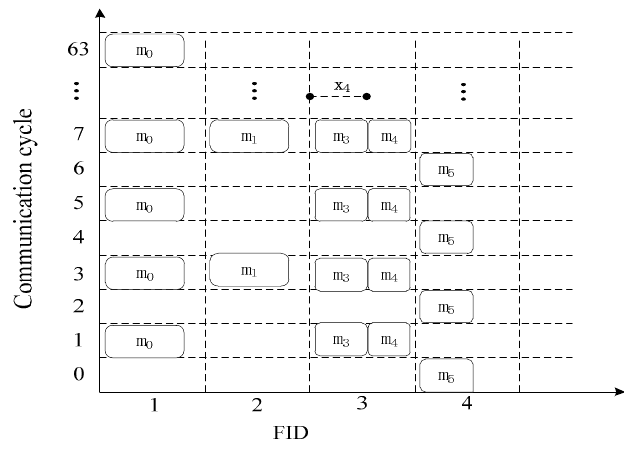
Figure 4. Frame schedule for FlexRay.